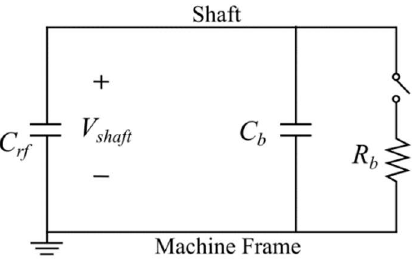
Figure 11. Unmodified induction motor bearing discharge equivalent circuit model.